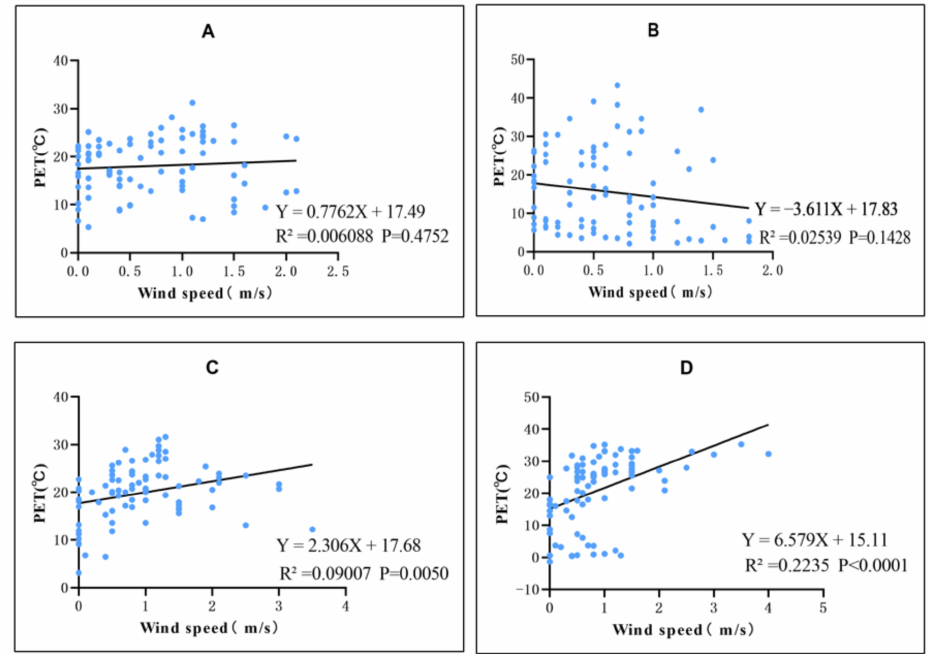
Figure 15. The relationship between PET and wind speed in different courtyards. (( A – D ) respectively represent the number of the courtyard under